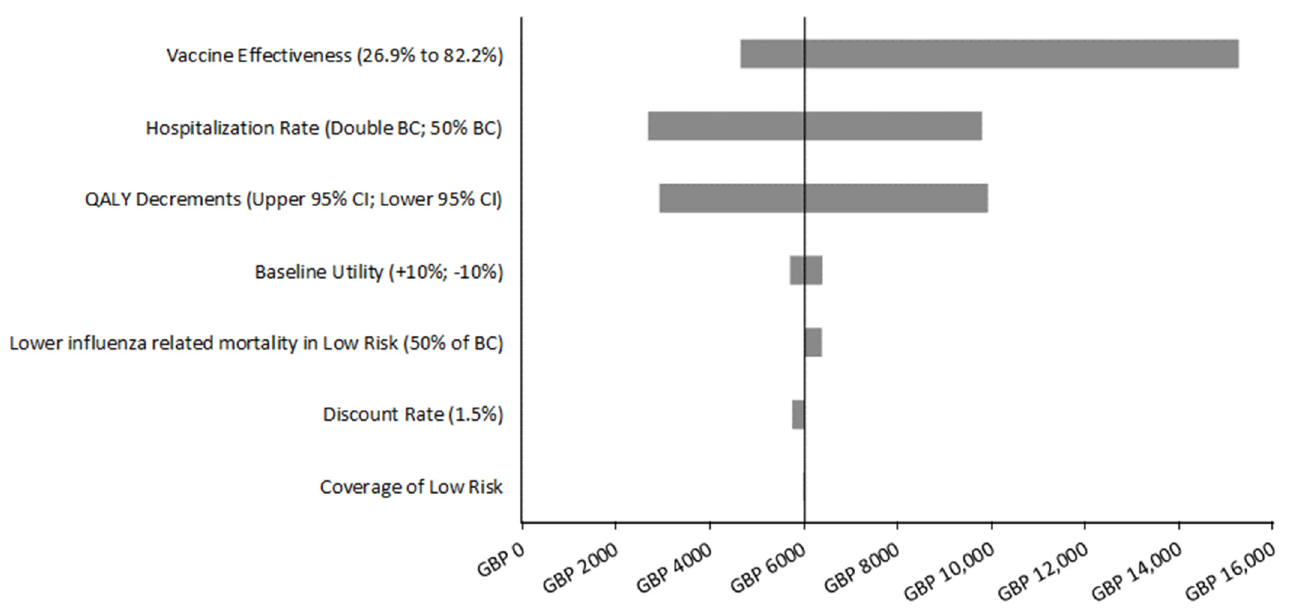
Figure 1. Tornado diagram: impact of the deterministic sensitivity analyses on the incremental cost per quality-adjusted life-year (NHS cost perspective) associated with vaccinating 50% of low risk individuals ages 50 to 64 years old.